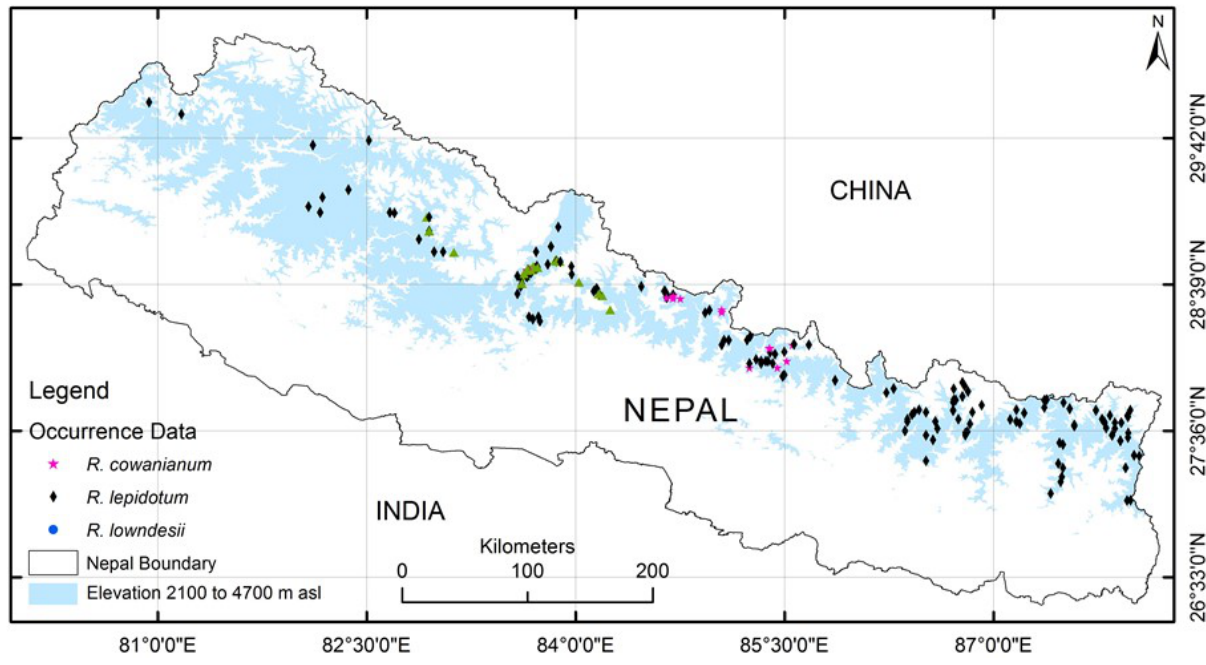
Figure 1 . Study area map depicting an elevation range of three Rhododendron sister taxa (2100 to 4700 m a.s.l. with light blue colour) and their recorded presence locations with different